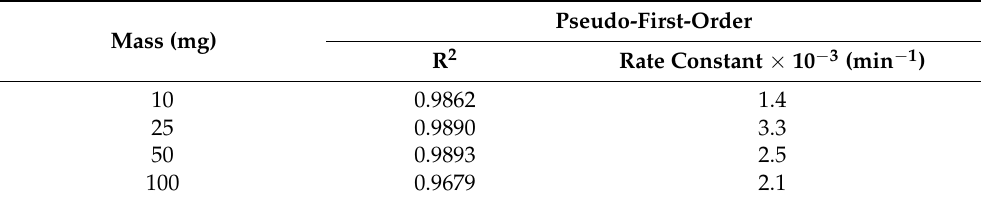
Table 5. Pseudo-first-order rate constants showing the effect of weight of the catalyst on the photocat- alytic